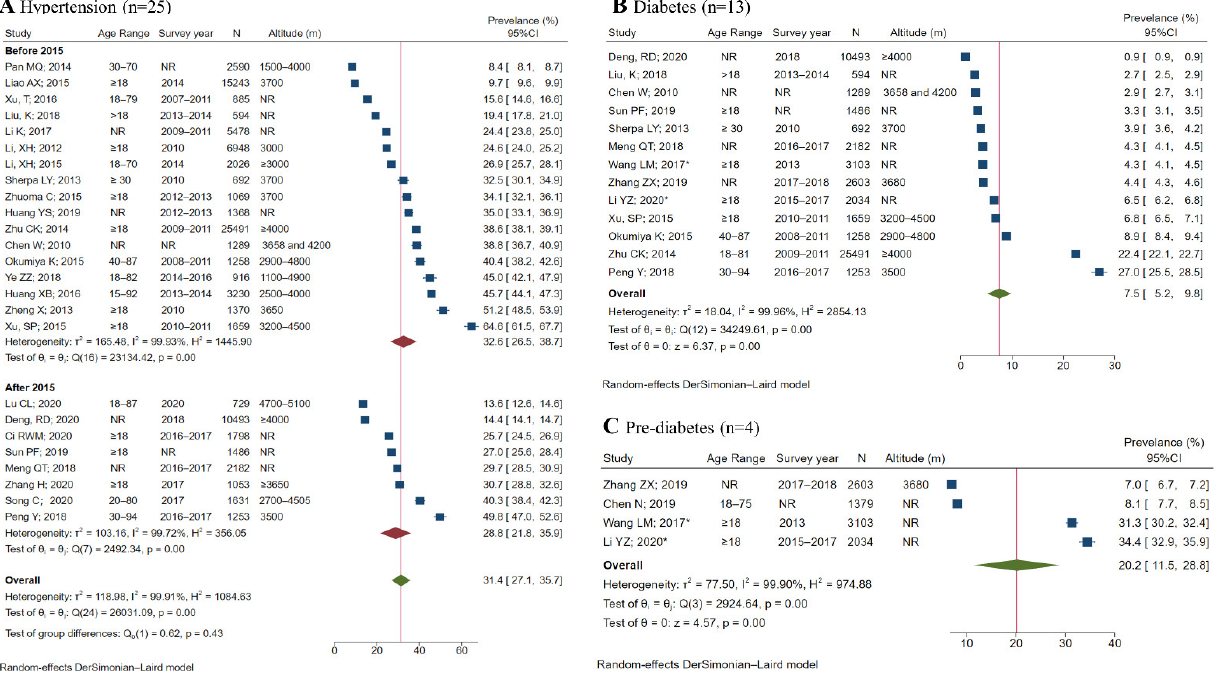
Figure 3. Meta-analysis of pooled prevalence of hypertension and diabetes among Tibetan adults [25,26,29-32,34,36-44,46,47,49,50-53,56-61]. Abbreviations: NR: not reported; M: mean; SD: standard deviation. *: nationally representative survey. Diagnostic criteria: hypertension was defined as systolic blood pressure (SBP) ≥ 140 mmHg, and/or diastolic blood pressure (DBP) ≥ 90 mmHg, and/or a history of hypertension, and/or reported current treatment with antihypertensive medications. Diabetes was defined as self-reported diabetes, and/or fasting plasma glucose (FPG) ≥ 7.0 mmol/L, and/or two-hour plasma glucose ≥ 11.1 mmol/L; pre-diabetes was defined as any participants without diabetes but with an FPG level of 5.6 mmol/L to 6.9 mmol/L, and/or two-hour plasma glucose level of 7.8 mmol/L to 11.0 mmol/L. Prevalence was calculated using the random- effects model. Prevalence and 95% CI were calculated using random-effects models.